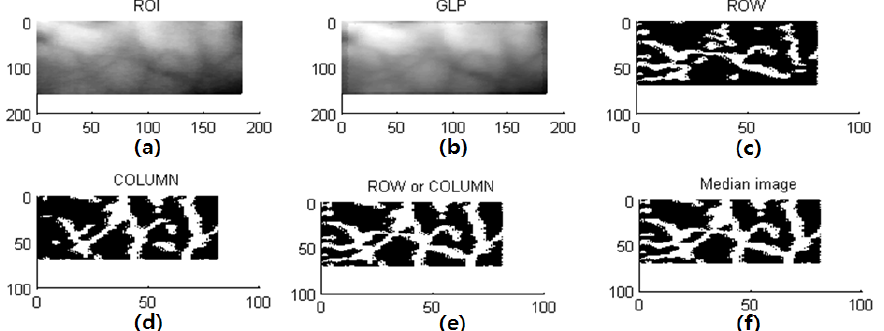
Figure 13. Curvatures estimate. ( a ) the ROI for preprocessing of vascular pattern; ( b ) Gaussian filter; ( c ) row vascular-pattern extraction filter; ( d ) column vascular-pattern extraction filter; ( e ) row or column vascular-pattern; and ( f ) median